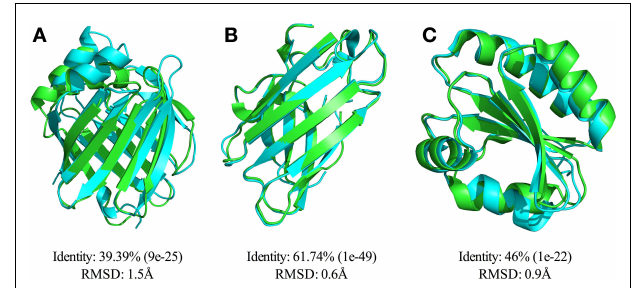
FIGURE 4 | Comparison of the structures of SmLipocalin, SmThioredoxin, SmSOD with their respective IgE-binding counterparts identified fromAllergome . Parasite allergen-like molecules were used to identify similar allergens by BLAST search of the Allergome database. Identities of the matched allergens with the corresponding E -values are shown below each matched pair. Structures were superimposed using LSQMAN and the quality of the alignment assessed by root mean squared deviation (RMSD). (A) Alignment of SmLipocalin (1VYF, cyan) and Der f 13 (2A0A, green). (B) Alignment of SmSOD (1TO4, cyan) andTomato SOD (3HOG, green). (C) Alignment of SmThioredoxin (2XBI, cyan) andWhite ShrimpThioredoxin (3ZZX, green).